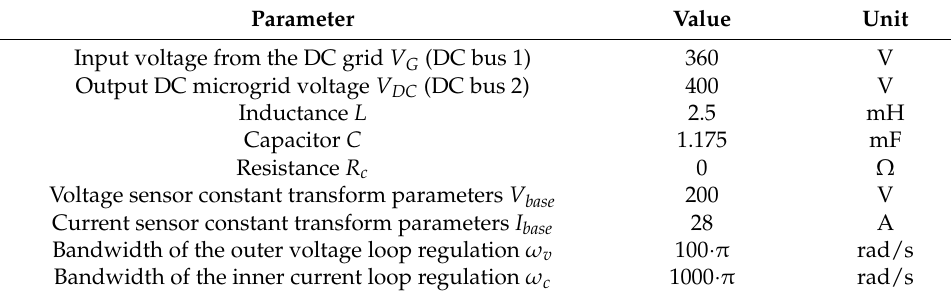
Table 1. Nominal parameters for the power electronic converter. Parameter Value Unit Input voltage from the DC grid V G (DC bus 1) 360 V Output DC microgrid voltage V DC (DC bus 2) 400 V Inductance L 2.5 mH Capacitor C 1.175 mF Resistance R c 0 Ω Voltage sensor constant transform parameters V base 200 V Current sensor constant transform parameters I base 28 A Bandwidth of the outer voltage loop regulation ω v 100 · π rad/s Bandwidth of the inner current loop regulation ω c 1000 · π